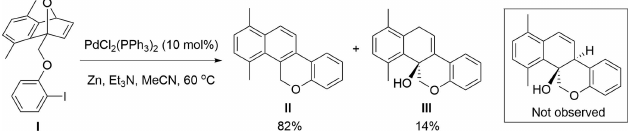
Figure 1 The reaction scheme